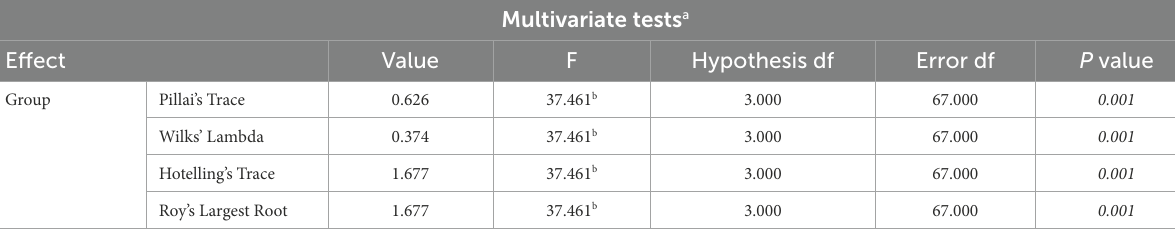
TABLE 4 The value of Wilkes’s Lambda test in the analysis of multiple variances of research variables.